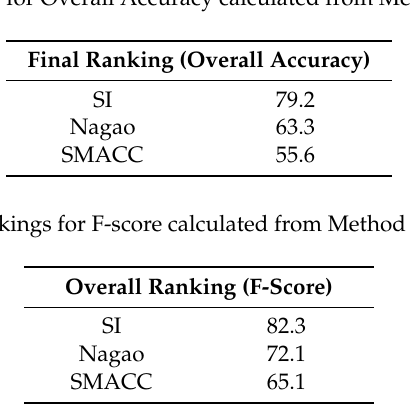
Table 8. Final rankings for Overall Accuracy calculated from Method Mean in Table 6.